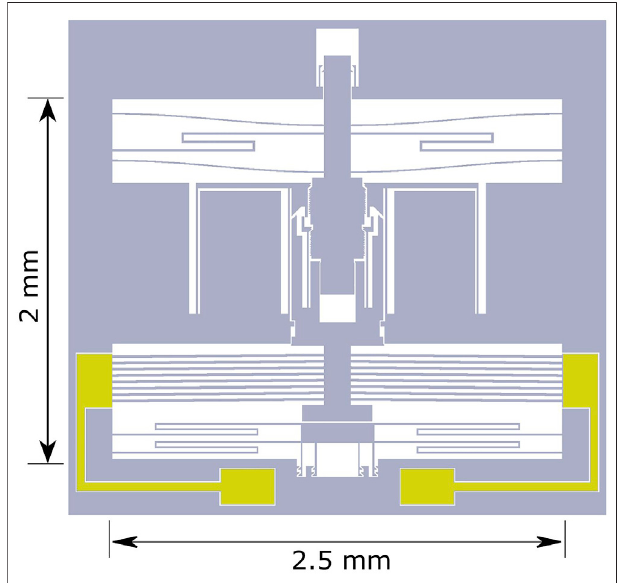
FIGURE 2 | Layout of the multistable